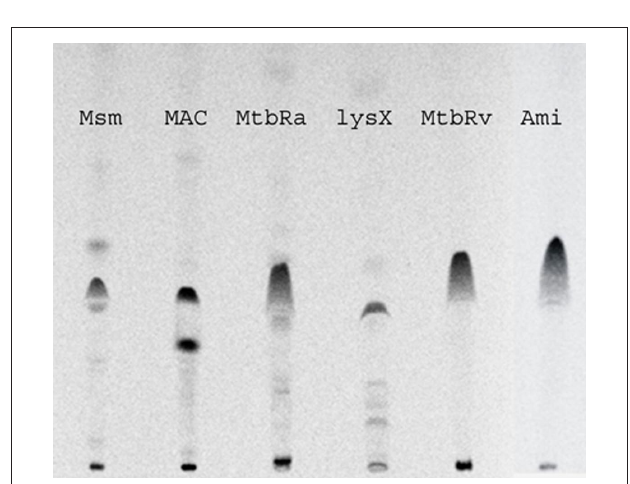
FiguRe 8 | Turnover of M. tuberculosis phospholipids following 14 C-acetic acid incorporation. Total lipids were extracted and analyzed by TLC. Radioactive spots corresponding to each phospholipid were identified, lipids were extracted and radioactivity present in each spot was measured by scintillation counting. Closed symbols stand for ∆ lys X and open ones correspond to RvWT.